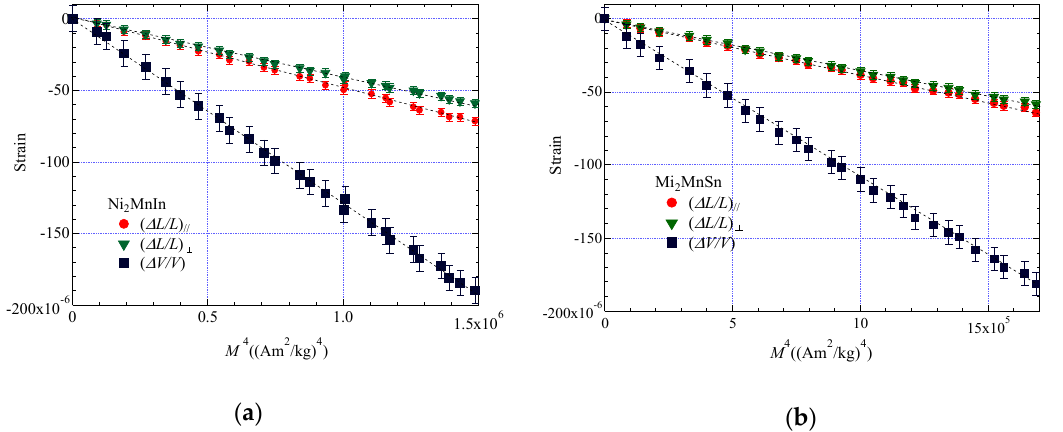
Figure 5. Forced magnetostriction vs. M 4 at T C : ( a ) Ni 2 MnIn; ( b ) Ni 2 MnSn at T c. Dotted straight lines are linearly fitting lines.